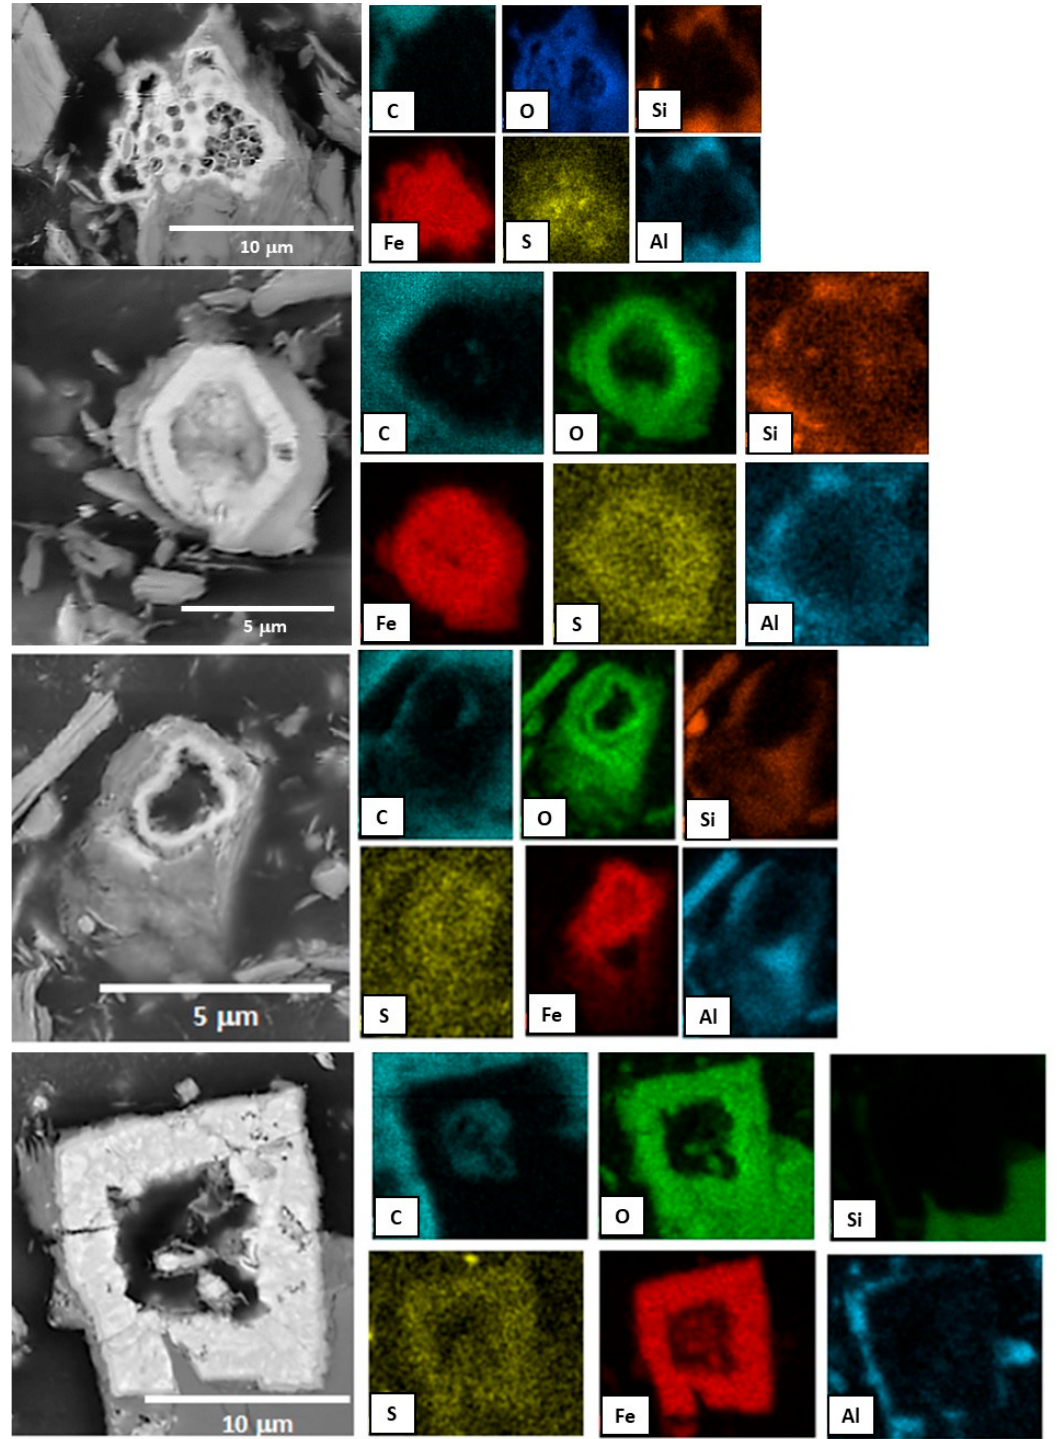
Figure 4. Representative SEM images collected in the backscattered mode and EDS element maps from the mine spoil soil samples from 0–10, 30–40, 70–80, and 110–120 cm (in descending order).